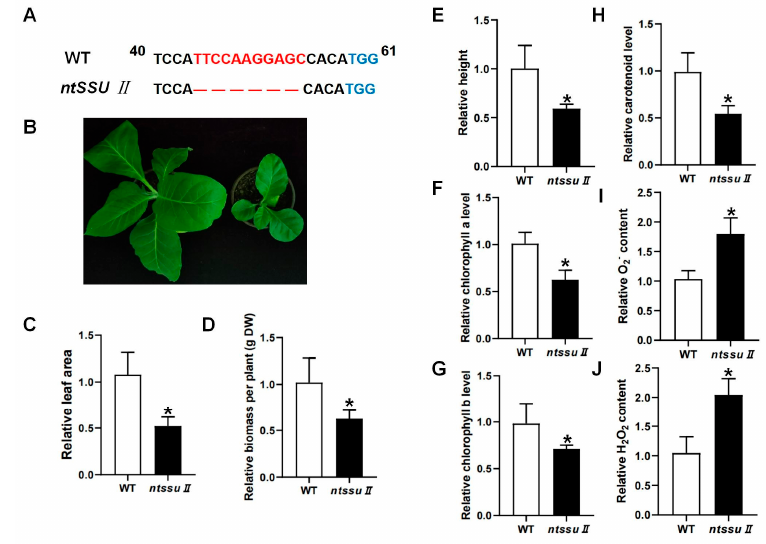
Figure 6. Phenotype of ntssu Ⅱ transgenic tobacco and identification of carotenoids and chlorophyll contents. ( A ) Sequences analysis of ntssu Ⅱ mutant. The TGG indicated in blue was the PAM, and the red fonts represented the nucleotide bases deletion generated by the CRISPR/Cas9 system in ntssu Ⅱ mutants. ( B ) The phenotype of ntssu Ⅱ mutant. ( C – E ) Relative leaf area, biomass, and plant height of ntssu Ⅱ mutant. ( F – H ) Relative contents of chlorophyll a, chlorophyll b, and carotenoid. ( I , J ) The relative contents of O 2 − and H 2 O 2 contents in ntssu Ⅱ mutant. Asterisks represent statistically significant differences between WT and transgenic plants determined by Student’s t-test (*, p < 0.05).